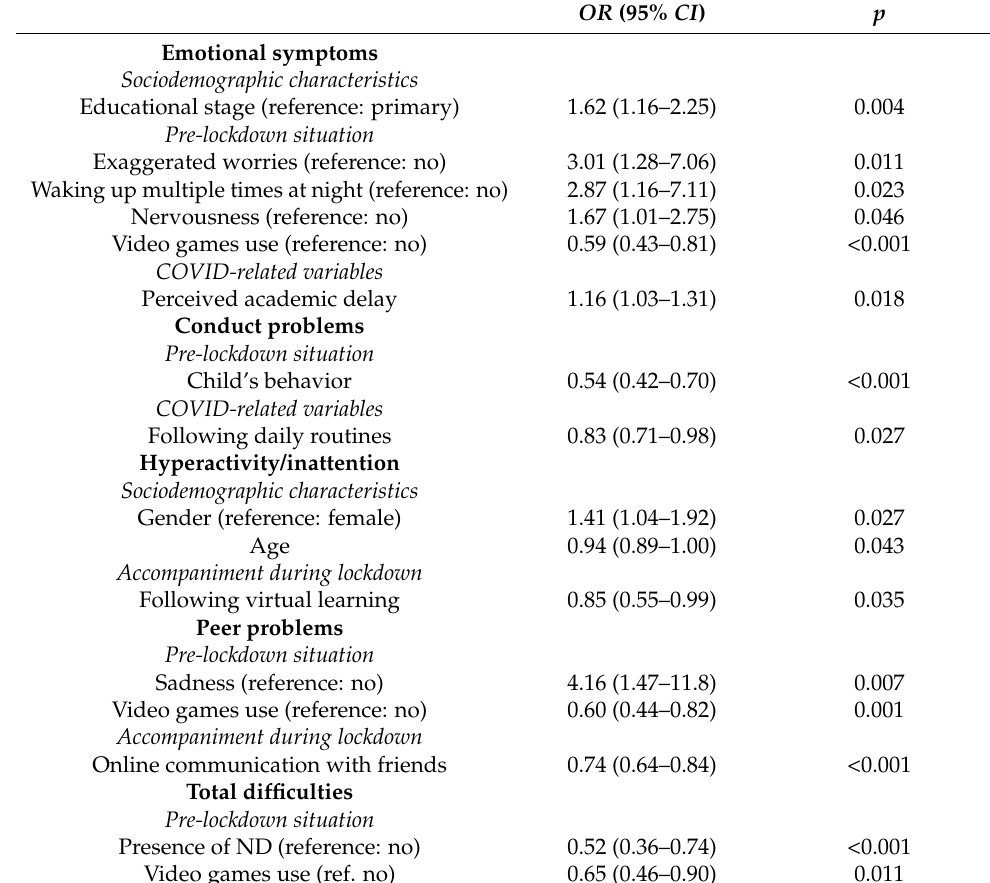
Table 3. Factors associated with impaired mental health during the COVID-19 lockdown according to parents ( N =